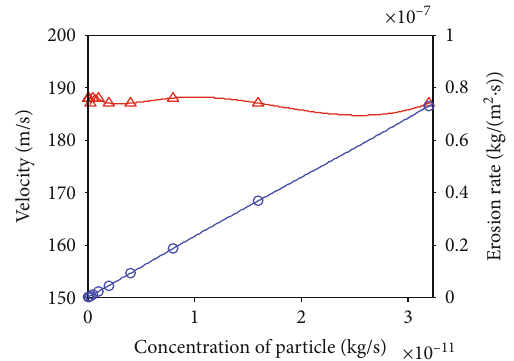
Figure 16: The relation curves among oil velocity, erosion rate, and particle ’ s concentration.